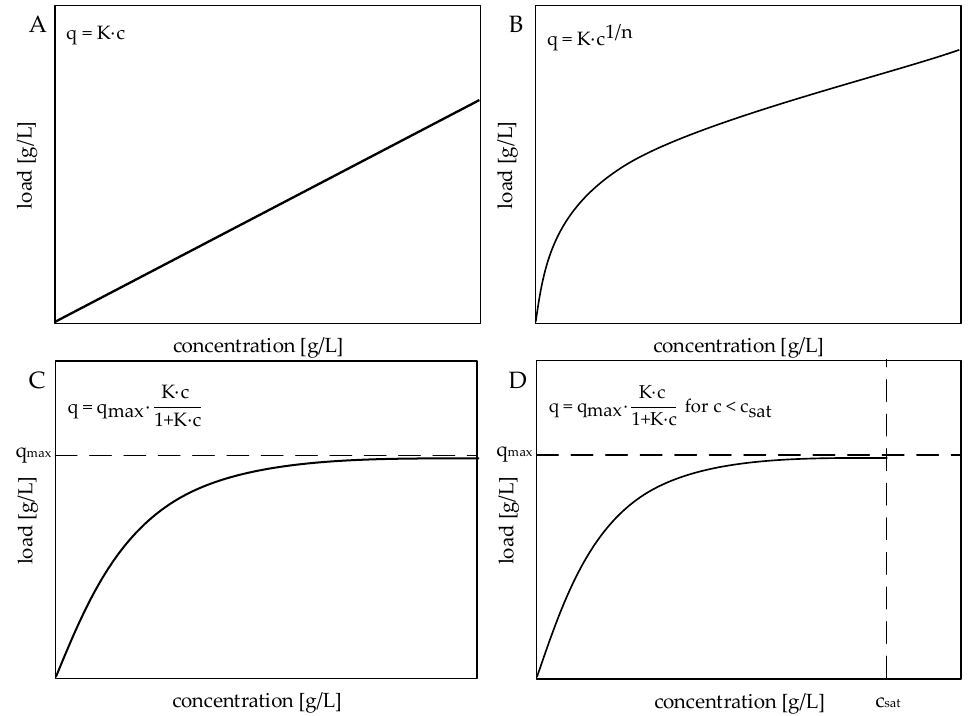
Figure 3. Solid-liquid equilibria according to Henry ( A ), Freundlich ( B ), Langmuir ( C ), and Langmuir with saturation concentration ( D ).